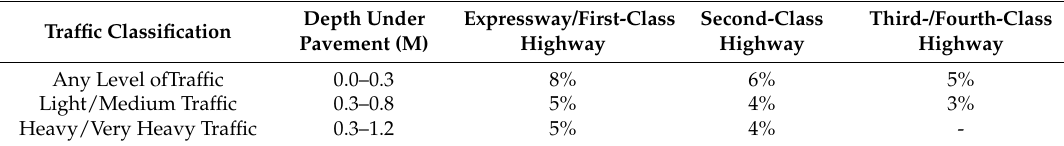
Table 4. Minimum CBR of roadbed materials [37] .